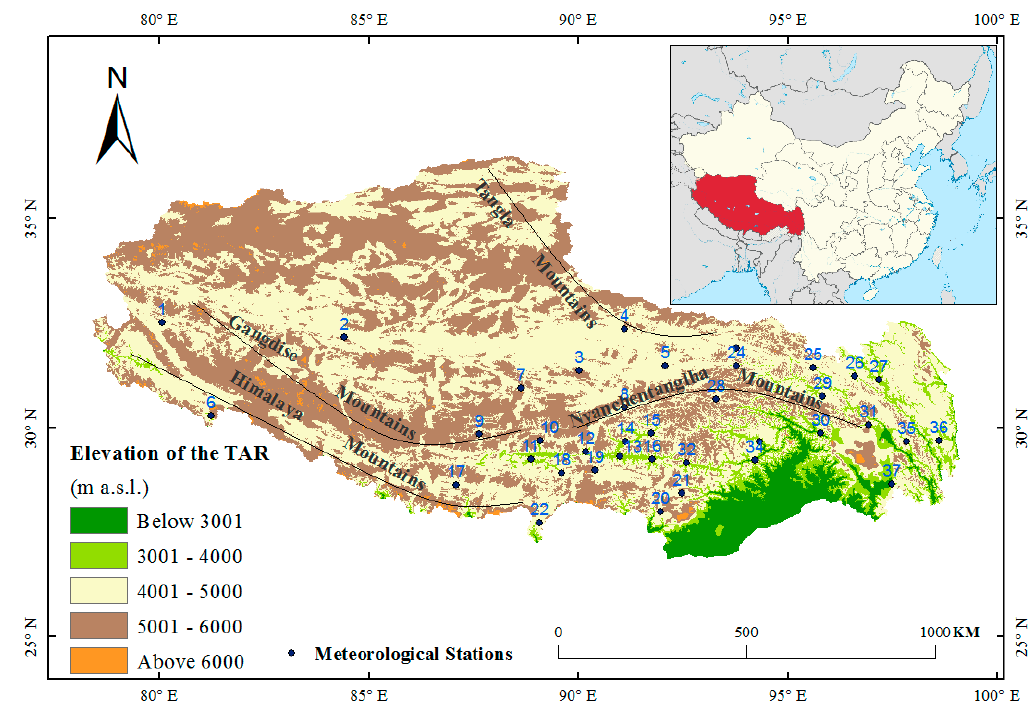
Figure 1. Map of the study area with altitude intervals and the location of the 37 stations indicated. The black curves indicate mountain ridges that are mentioned in the text. Upper right corner: the map of China with Tibet Autonomous Region (TAR) in red.